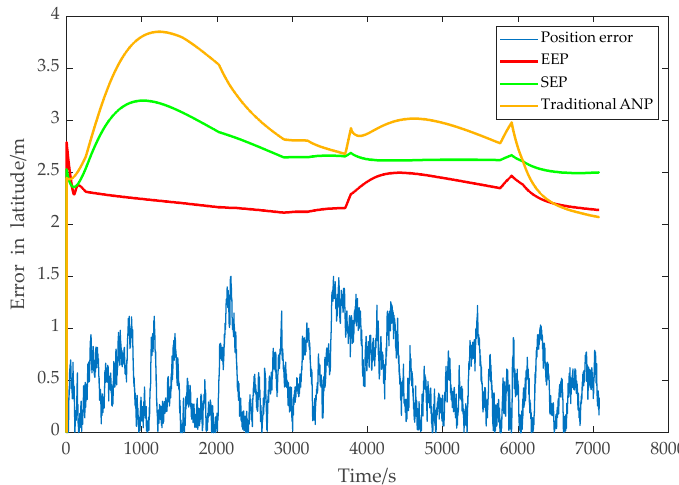
Figure 14. Comparison between latitude position error and ANP.